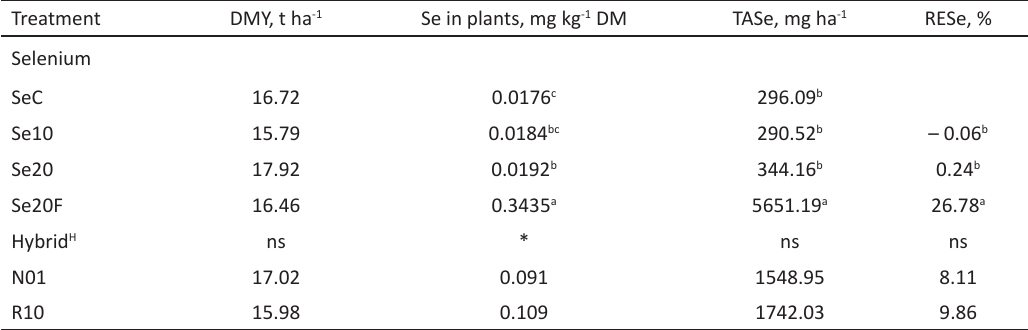
Table 4. Mean comparison of selenium concentrations in maize and biomass yield affected by the main effects of the experimental treatments in 2014 Treatment